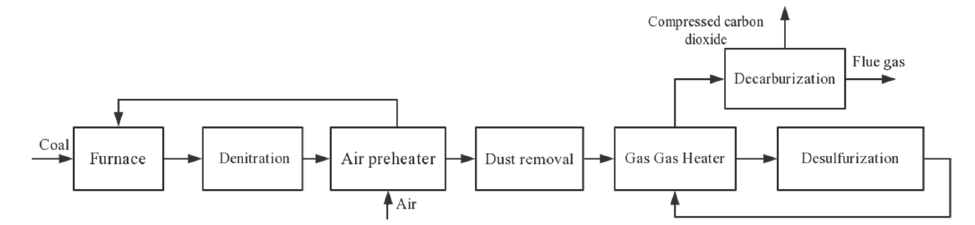
Figure 2. Flue gas treatment process in a coal-fired power plant.